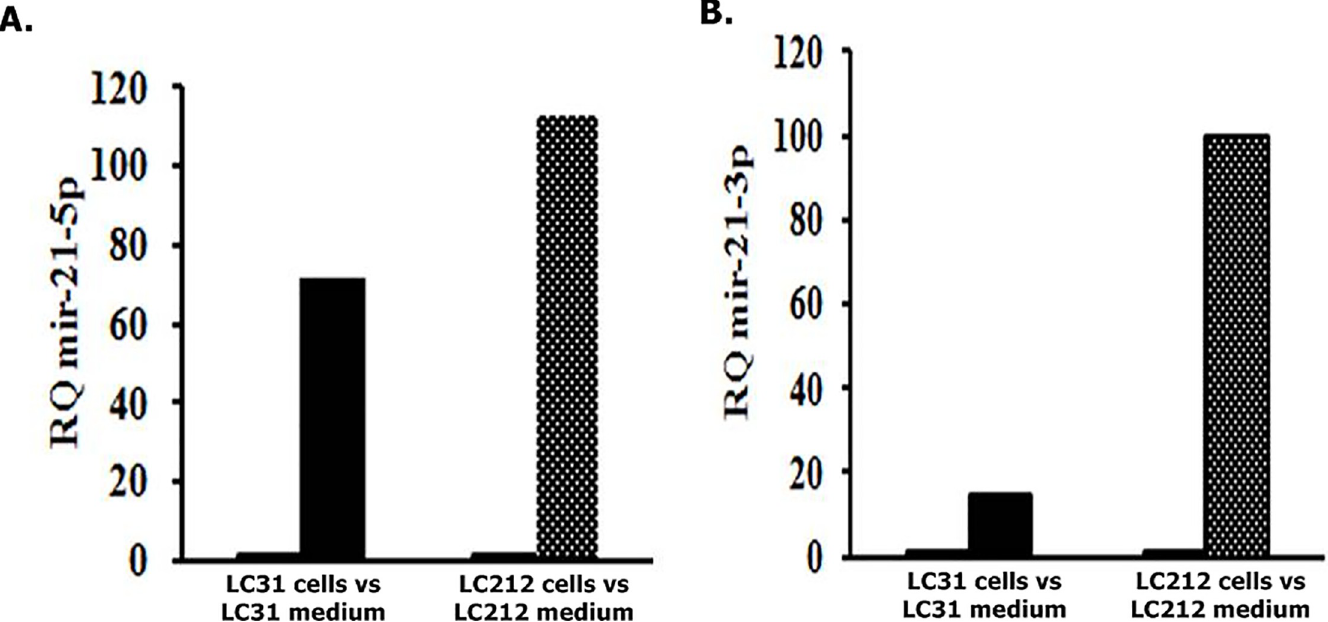
Fig 4. Relative expression of hsa-mir-21-5p and hsa-mir-21-3p. (A) Relative quantification of miR-21-5p in LC212 cells vs LC212CM and LC31 cell vs LC31 CM; (B) Relative quantification of hsa-mir-21-3p in LC212 cells vs LC212CM and LC31 cell vs LC31 CM. hsa-mir-21-3p was significantly most abundantly released outside the LC212 than the LC31